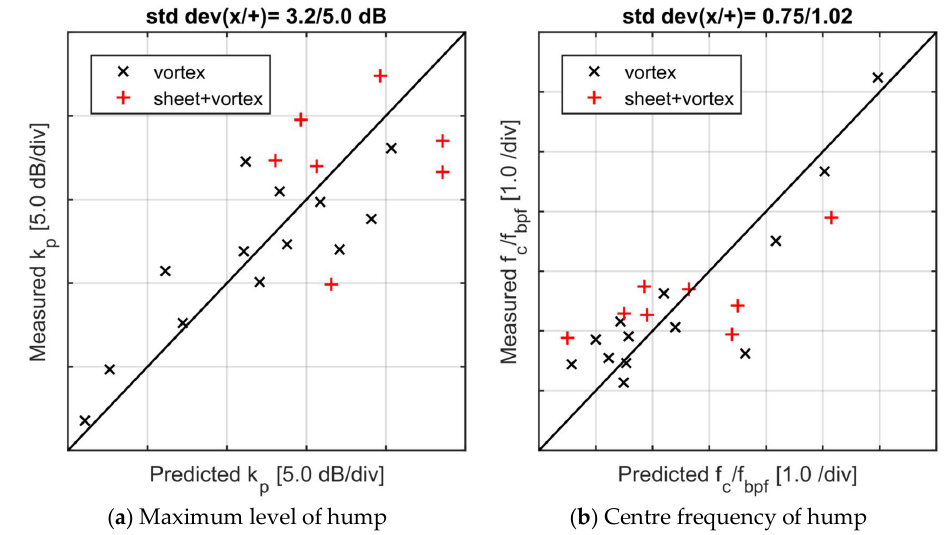
Figure 7. Comparison between measured and predicted levels and frequency of the centre of the hump for the cases used in the development of the method.